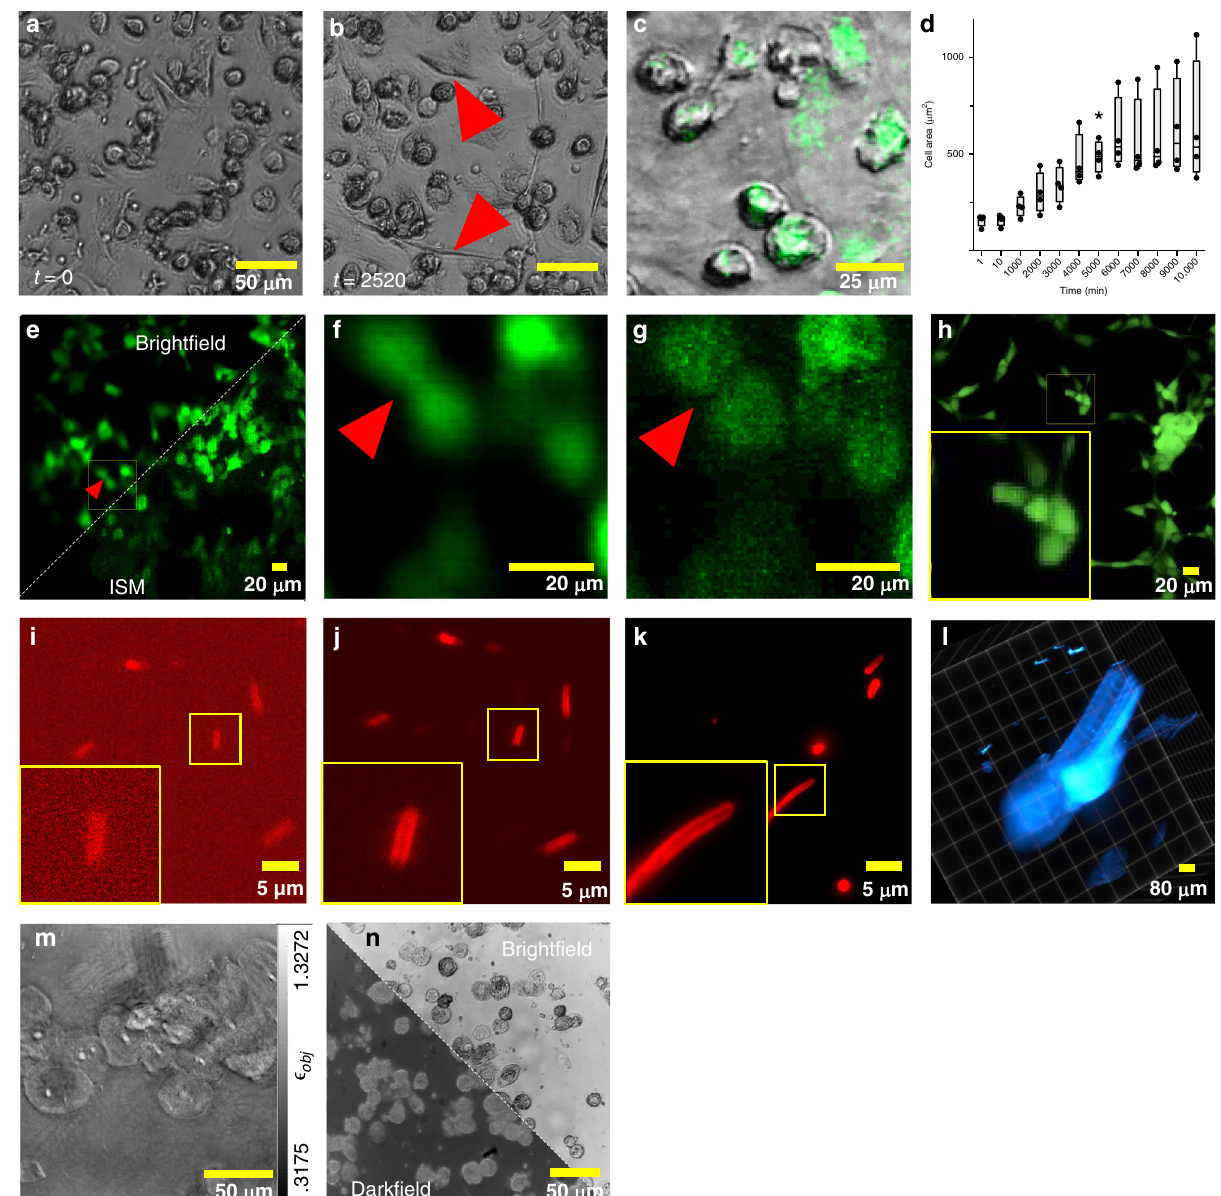
Fig. 3 UC2 imaging modalities. a , b Variation in macrophage ’ s morphology, where elongated cells are clearly visible after 42 h (red arrow) imaged in transmission mode. c The bright- fi eld channel superposed with a fl uorescent signal of fi xed macrophages labeled with CellTracker green captured with the incubator-enclosed microscope. d the growth of a differentiating cell is plotted as the average area of cells across multiple time-steps and different experiments ( n = 4). Whisker plots: 10 th − 90 th percentile, the box represents the 25 th and 75 th percentile with the line in the box marking the median. Statistical testing with one-way ANOVA and Tukey ’ s correction with GraphPad Prism (GraphPad, CA, USA), p = 0.034 ( F = 10.76, DF = 11). Data of four independent experiments is shown. e Wide- fi eld fl uorescence (top-left) and the computed “ superconfocal ” result (bottom-right) of GFP-labeled Human Pulmonary Microvascular Endothelial Cells (HPMCs) illuminated with a laser-scanning projector, recorded with a cellphone camera. The zoomed-in images show the improvement of the optical sectioning in the case of structured illumination ( g ) compared to wide- fi eld ( f ), where smaller cell-structures are lost. h A comparison of the same sample acquired with a commercial laser-scanning confocal microscope. A benchmark from the in fi nity-corrected fl uorescence microscope using the Raspberry Pi ( i ) and cellphone camera ( j ) and a research-grade microscope ( k ) of mCLING-ATTO 647N labeled fi xed E. coli bacteria, where the cellphone clearly resolved the bacterial membrane. l A Z-stack of a GFP-expressing zebra fi sh acquired with the UC2-light sheet. m Using an LED-ring as the illumination enables quantitative phase imaging of cheek cells using annular Intensity Diffraction Tomography (aIDT). n LED matrices can rapidly switch between bright- and dark- fi eld imaging as shown in ( n